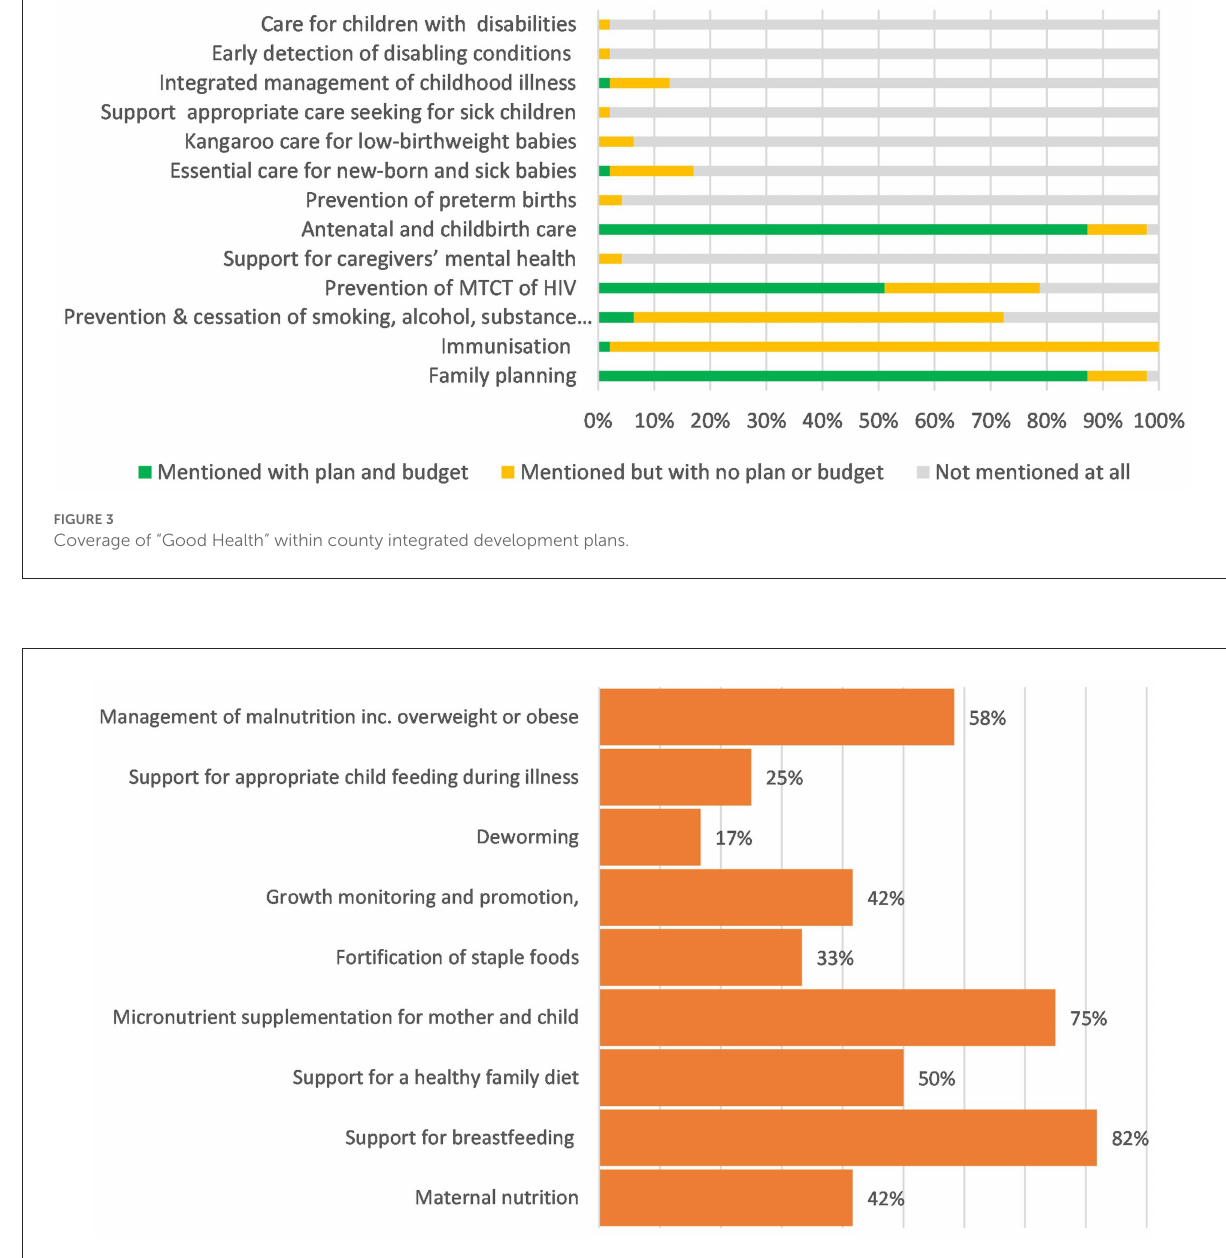
FIGURE4 Coverage of “Adequate Nutrition” within national